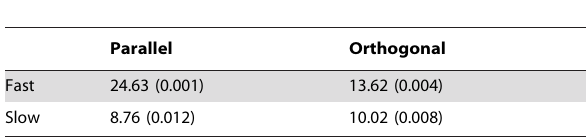
Table 1. T-values for single-sample t-tests comparing threshold elevations to a test value of 0 for each of the masking conditions, averaging across four